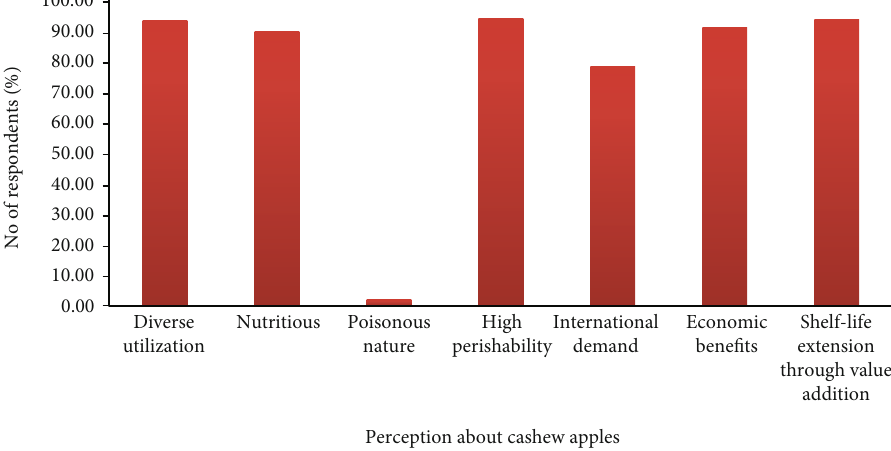
Figure 3: Cashew stakeholders ’ perception about cashew